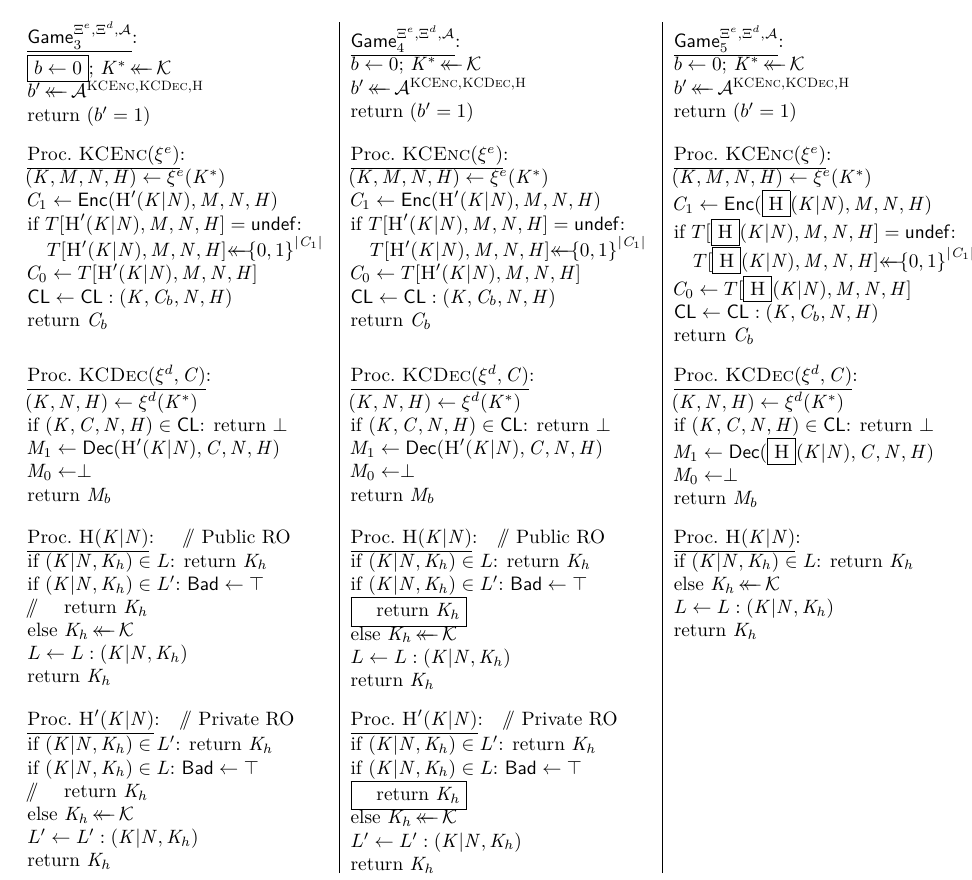
Figure 9: Game 3 changes the challenge bit to 0. Game 4 merges H and H 0 . Game 5 is functionally identical to Game 4 with merged H and H 0 . Game 5 is the KC-AE game with respect to SE and challenge bit